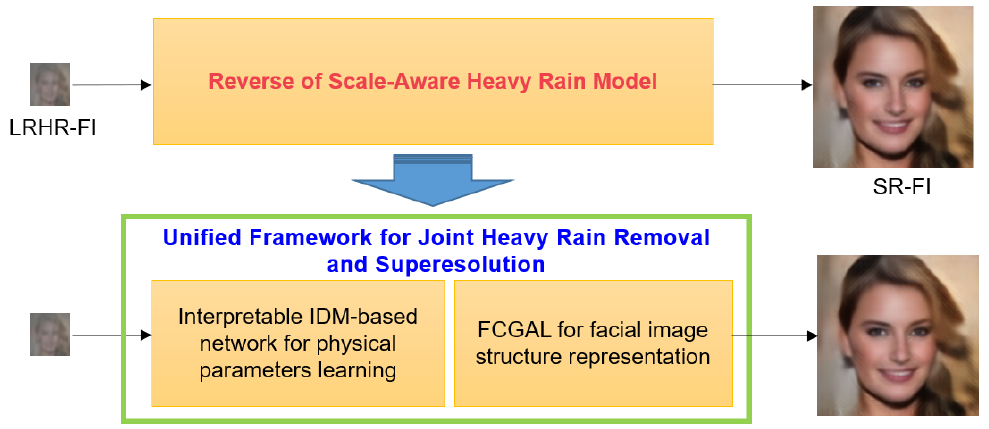
Figure 2. Proposed unified framework for the reverse of the scale-aware heavy rain model.